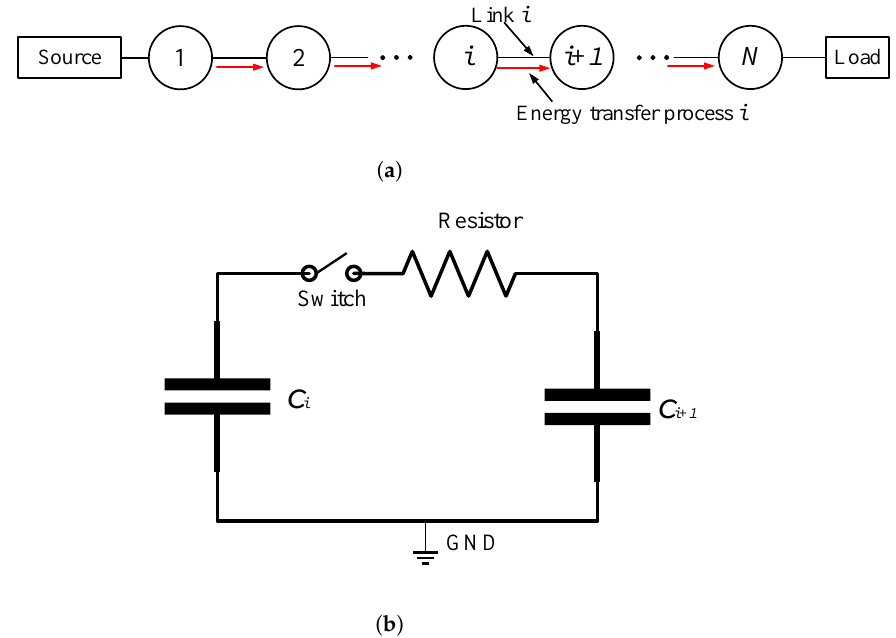
Figure 3. Energy flow from a source to a load and energy transfer process i . ( a ) Energy flow from a source to a load. ( b ) Energy transfer process i between two parallel